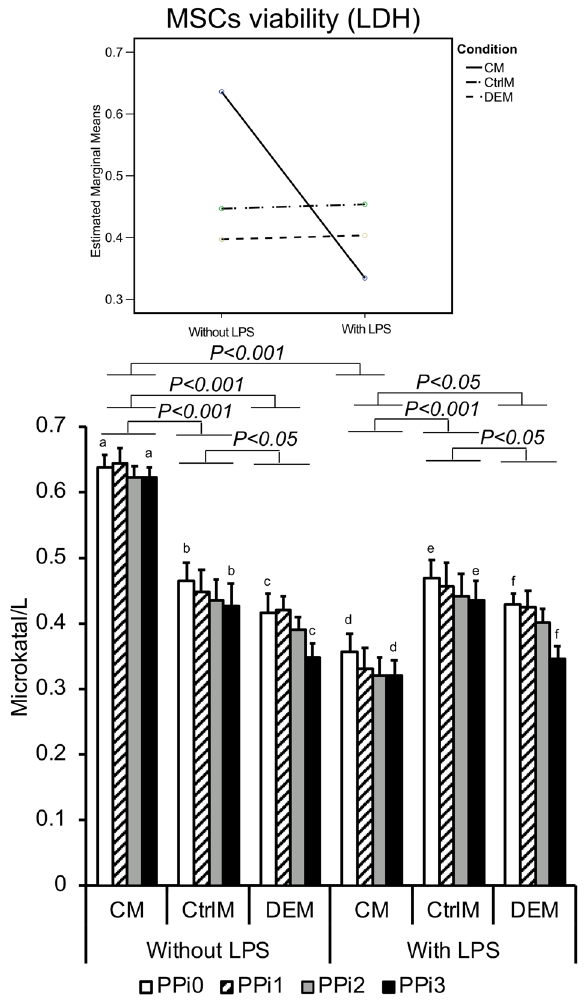
Fig. 4 Viability of mesenchymal stem cells (MSCs). The viability of MSCs was measured by lactate dehydrogenase (LDH) analysis. The LDH enzyme activity in the media of MSCs after 72 h of culture in different culture media: CM = conditioned media from monocytes incubated for 48 h in polystyrene well-plates in the presence or absence of lipopolysaccharide (LPS) and exposed to different pyr- ophosphate (PPi) concentrations; CtrlM = control media incubated for 48 h in polystyrene well-plates in the presence or absence of LPS and exposed to different PPi concentrations; DEM = direct effect media incubated for 48 h in 50 mL tubes and used for direct exposure of MSCs to LPS and different PPi concentrations. The different PPi concentrations were as follows: 0 μ M (PPi0), 50 μ M (PPi1), 100 μ M (PPi2) and 250 μ M (PPi3). The line graph (top) shows the interaction effect of culture condition and exposure to LPS, whereas the bar graph (bottom) shows the mean and standard error of the mean ( n = 4 – 5). Connected bars indicate signi fi cant differences ( P < 0.05; P < 0.001) between LPS and non-LPS as well as between the different conditions (CM, CtrlM, DEM). Small letters indicate signi fi cant differences between PPi concentrations (PPi0, PPi1, PPi2, PPi3), where each two similar letters indicate a statistically signi fi cant difference ( P < 0.05) between the two concentrations they are